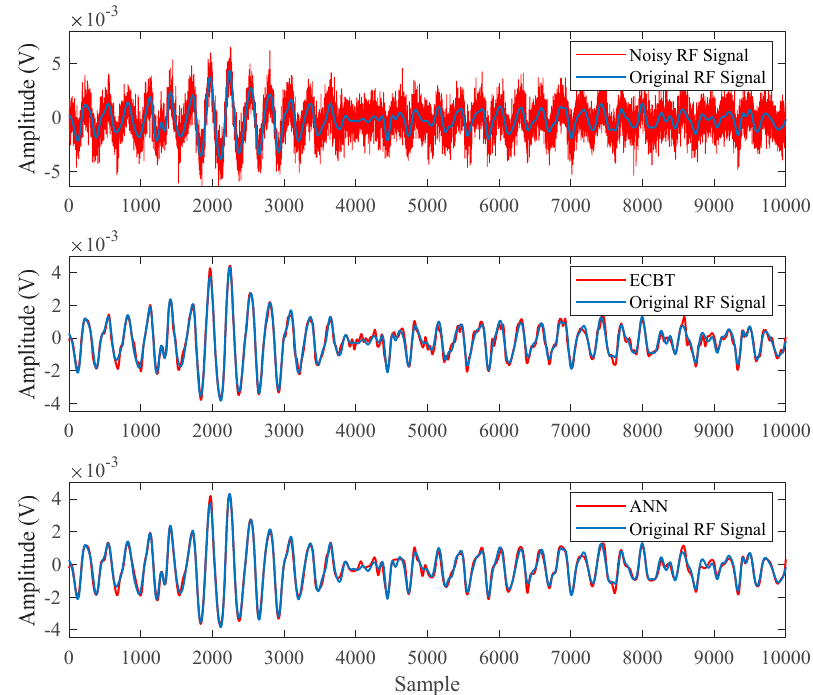
Energies 2019 , 12 , x FOR PEER REVIEW 11 of 14 Figure 11. Denoising of RF signal, ‘sharp point’ type, in the case of PSNR = 1.